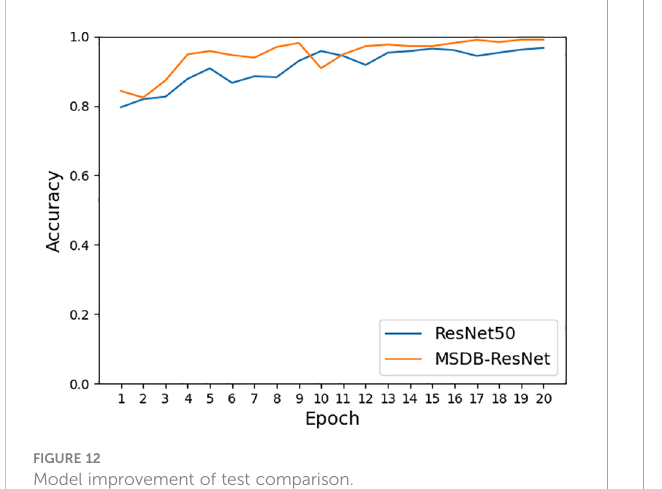
FIGURE 15 GAN AugmentData and model improvement.